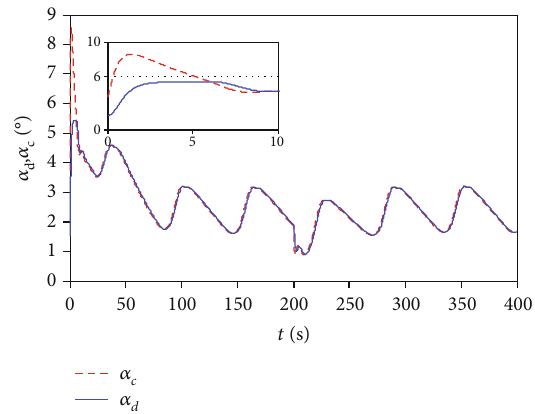
Figure 8: Curves of limited AOA command of scheme A.